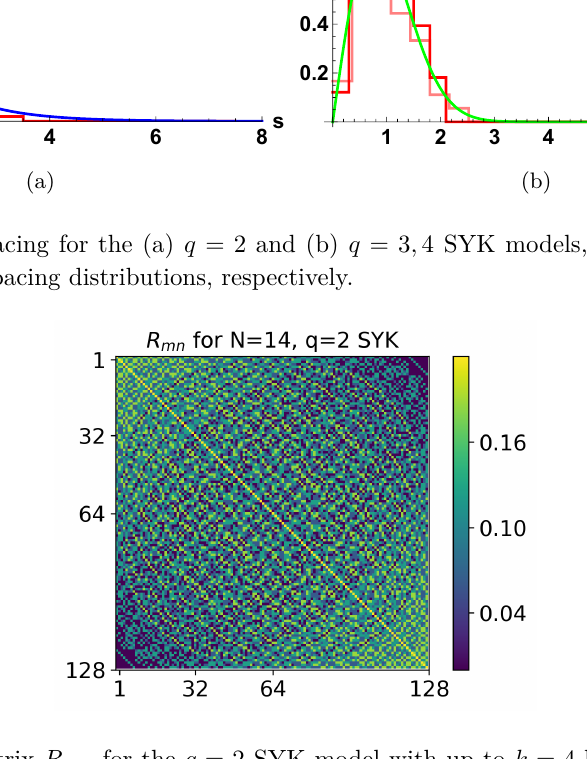
Figure 15 . ECH matrix R mn for the q = 2 SYK model with up to k = 4 -local operators consid- ered